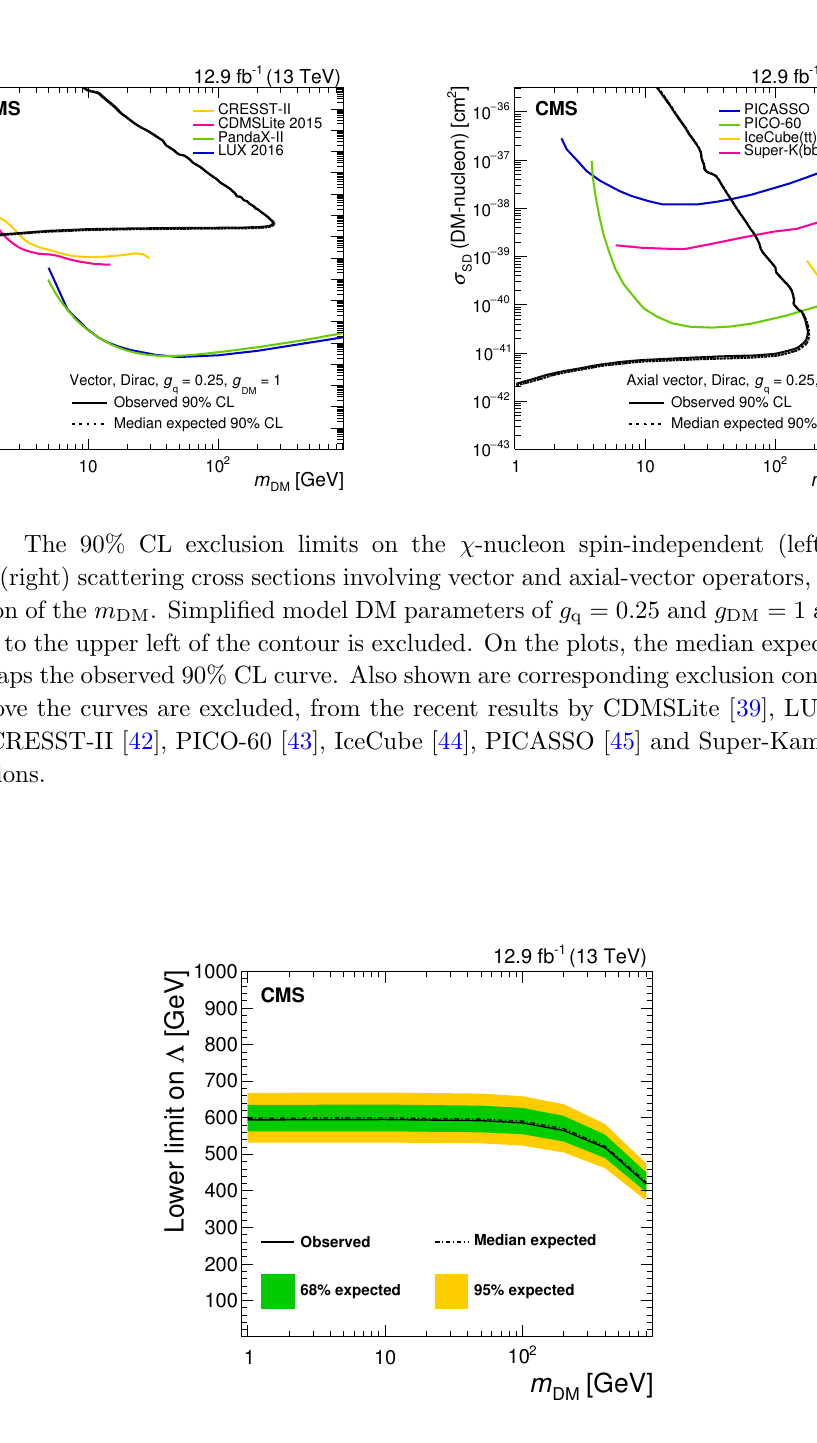
Figure 5 . The 95% CL expected and observed lower limits on (cid:3) as a function of m DM , for a dimension-7 operator EFT model assuming k 1 = k 2 = 1.